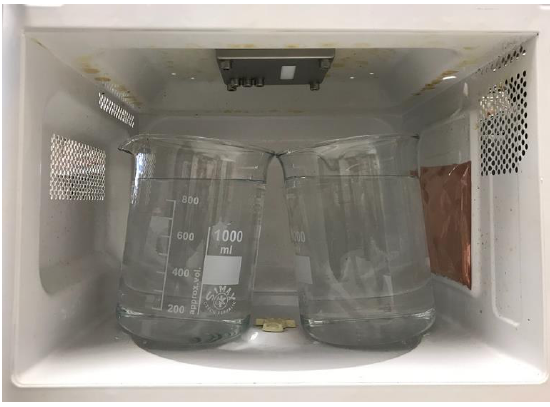
Figure 7. Picture of the antenna feeding the microwave applicator with the two water recipients set up for the IMPI test.